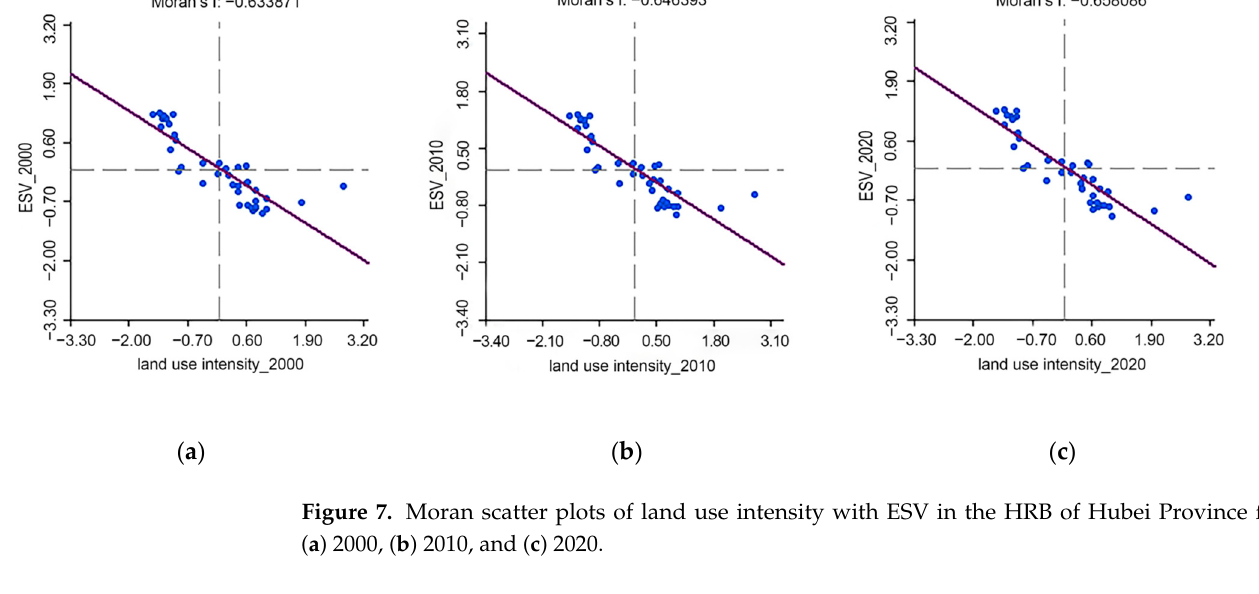
Figure 8. LISA cluster maps between land use intensity and ESV in the HRB of Hubei Province for ( a ) 2000, ( b ) 2010, and ( c ) 2020. 3.4. Spatial Variability of Driving Factors on ESV Changes 3.4.1. Results of GDM The factor detection module of the GDM was used to quantify the impacts of natural and socio-economic factors on ESV (Table 5). Among the natural factors, the percentages of forest land (X4) and slope (X3) had the greatest explanatory power (with q values of 0.87 and 0.81, respectively) for ESV spatial variation. Regarding the socio-economic factors, the explanatory power of the percentage of built-up land (X10) and GDP (X6) on ESV variations was 0.74 and 0.65, respectively, and both were significant at the 1% level. Only